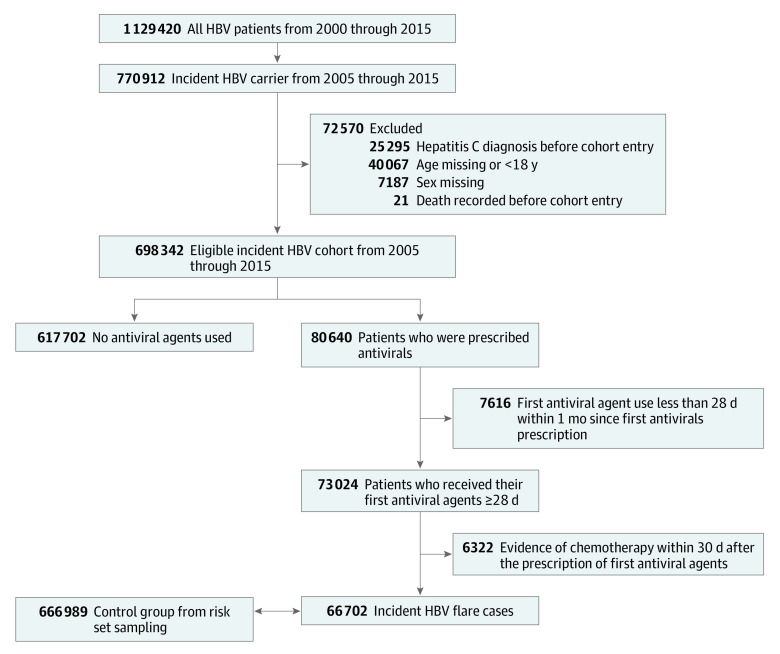
Flowchart of Case and Matched Control SelectionHBV indicates hepatitis B virus.